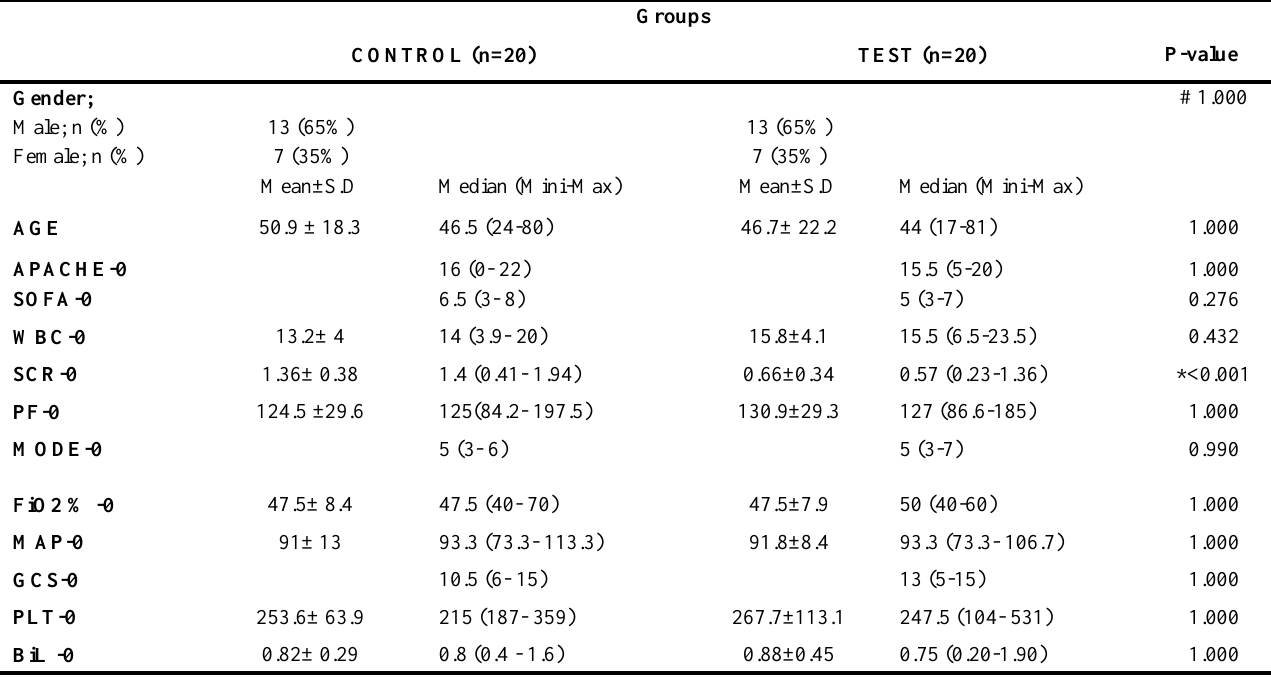
Table 1. Baseline comparison between the control and the test groups